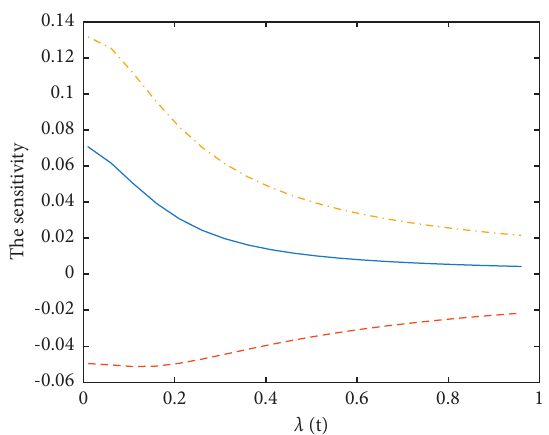
Figure 5: The sensitivity of jump intensity on CDS prices under the Vasicek model.